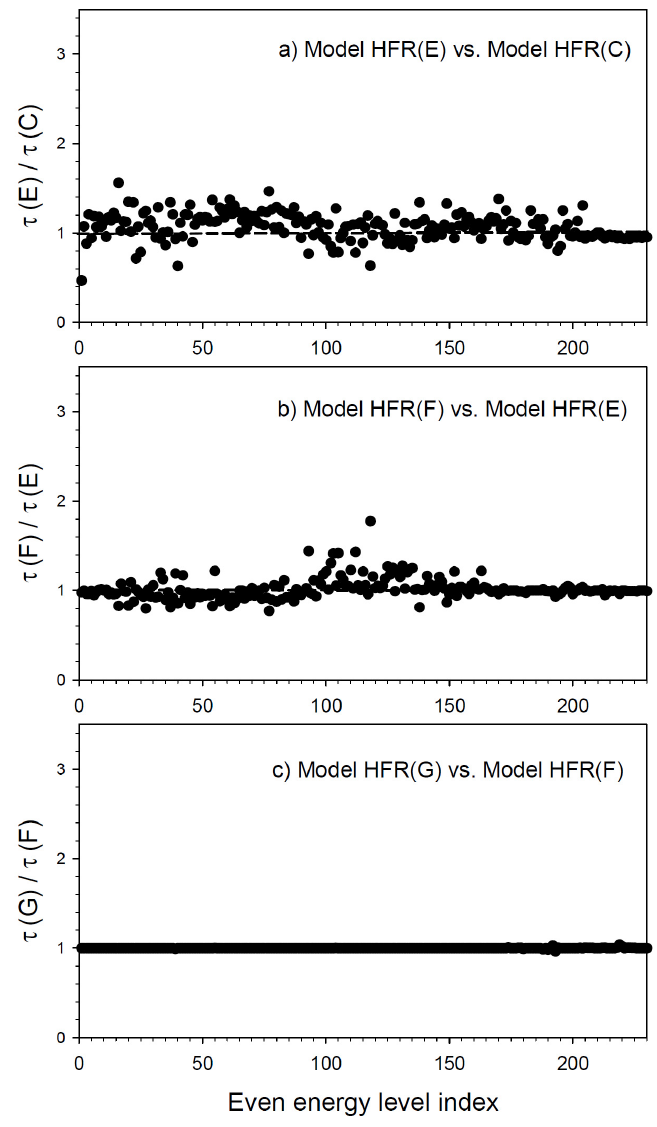
Figure 2. Comparison between radiative lifetimes obtained in the present work using different HFR models for short-lived even-parity energy levels ( τ < 100 ns) in W VIII. In each panel, the y-axis gives the ratio of τ -values computed with two successive models including both single and double excitations (see text) while the x-axis corresponds to the level indexes, assigned according to the order of increasing